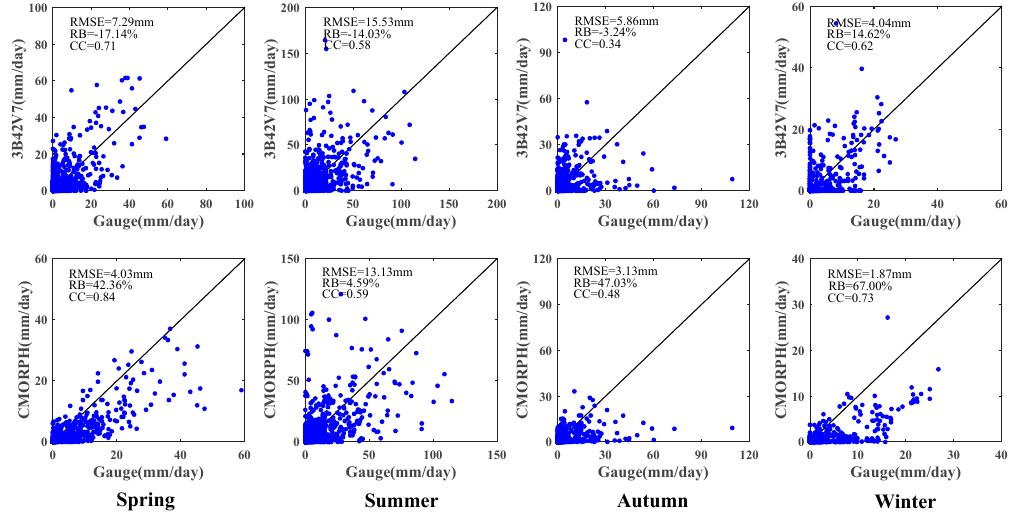
Figure 7. Scatter plots of daily rainfall from rain gauge data and 3B42V7 (CMORPH) data in four seasons (Spring: 1 March to 31 May; Summer: 1 June to 31 August; Autumn: 1 September to 30 November; Winter: 1 December to 27 February in second year).